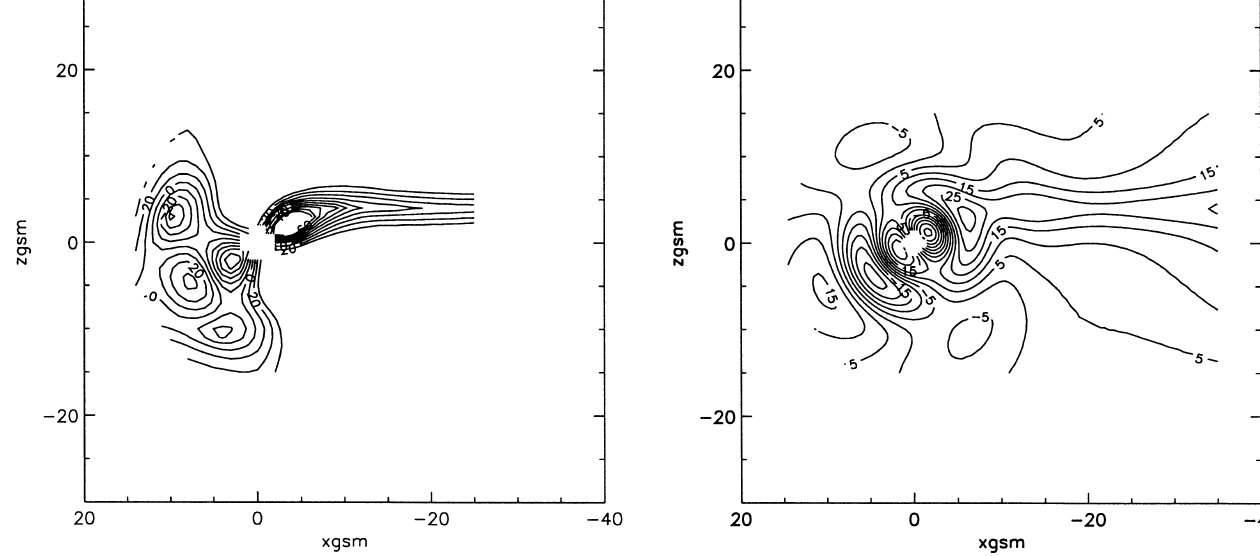
Fig. 10. The D B contours are obtained for Kp = 5 and tilt = 35 (cid:14) . The ring current depression reaches (cid:255) 50 nanoteslas in the day side and is lower than (cid:255) 60 nanoteslas in the night side. The step between two contours is